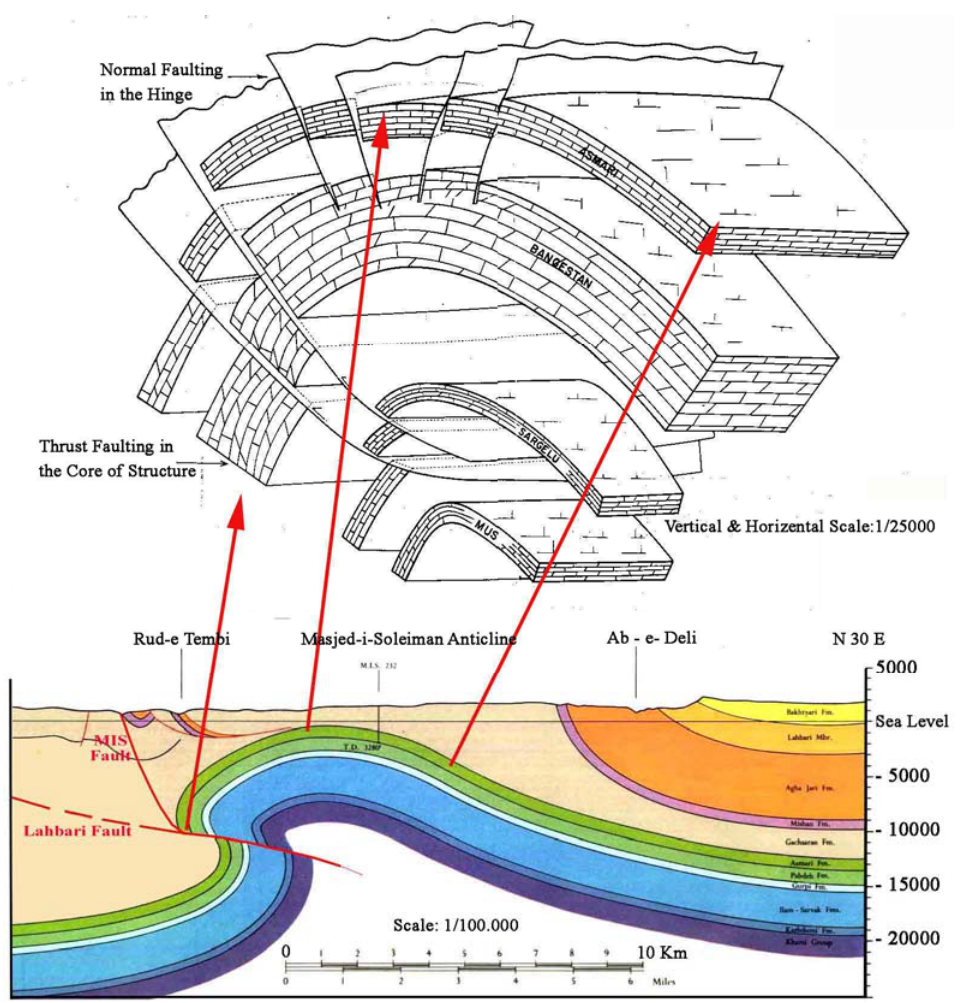
Figure 5. Formation of Masjed-i-Soleiman anticline due to activity of MIS fault zone (Modified from Keyhanfar 1995 and NIOC 1967)